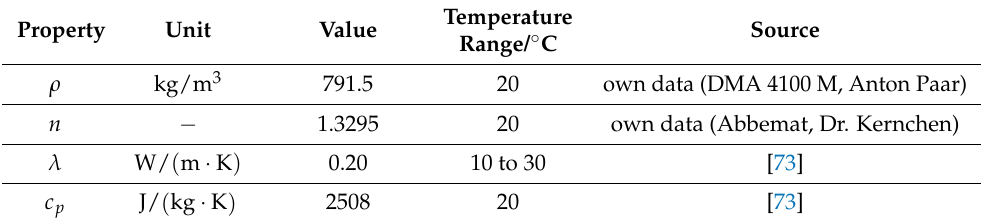
Table A1. Material properties of pure liquid methanol.